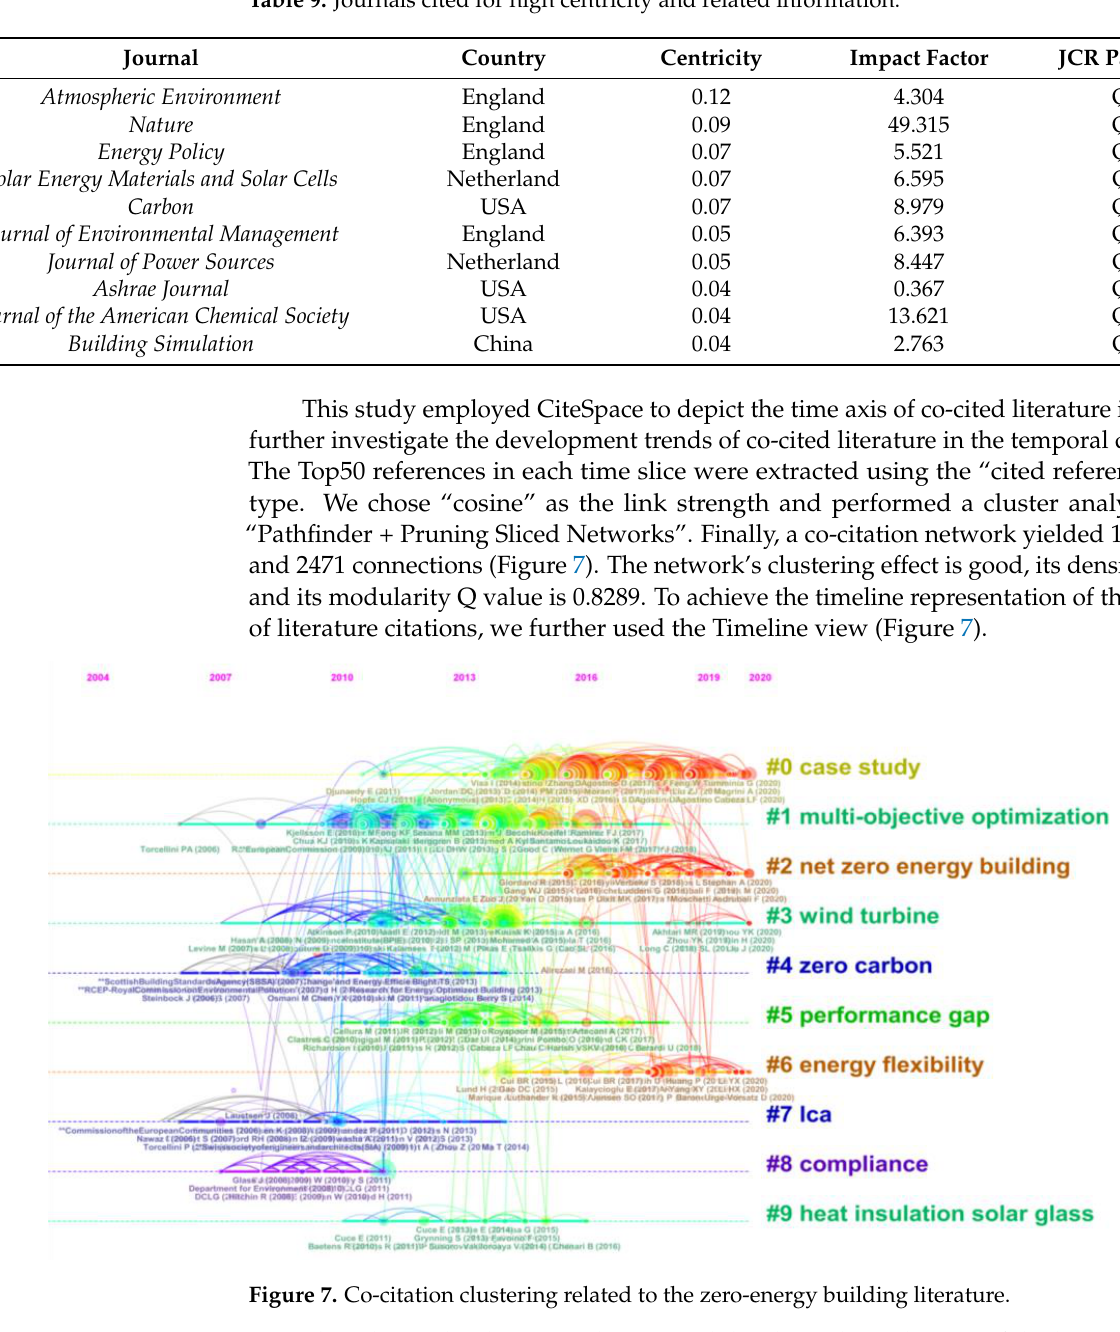
Table 9. Journals cited for high centricity and related information.